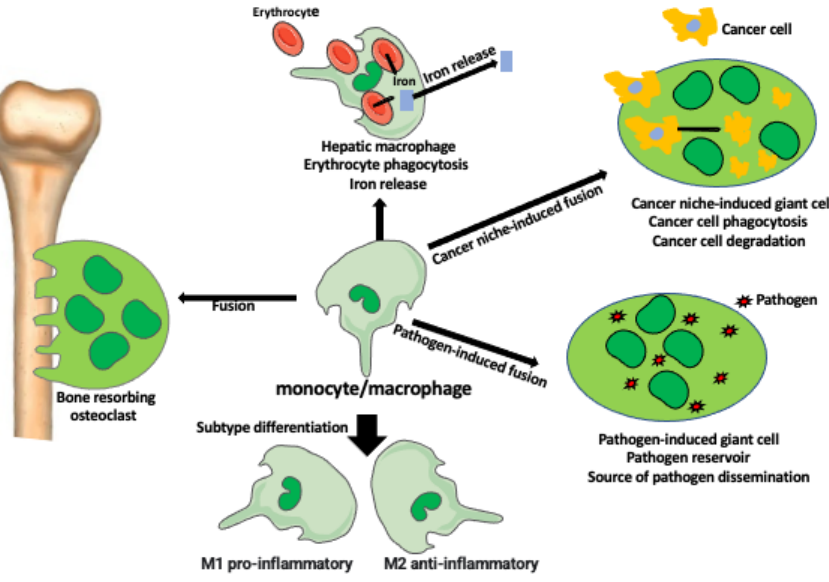
Figure 1. Diversity of macrophage functions.